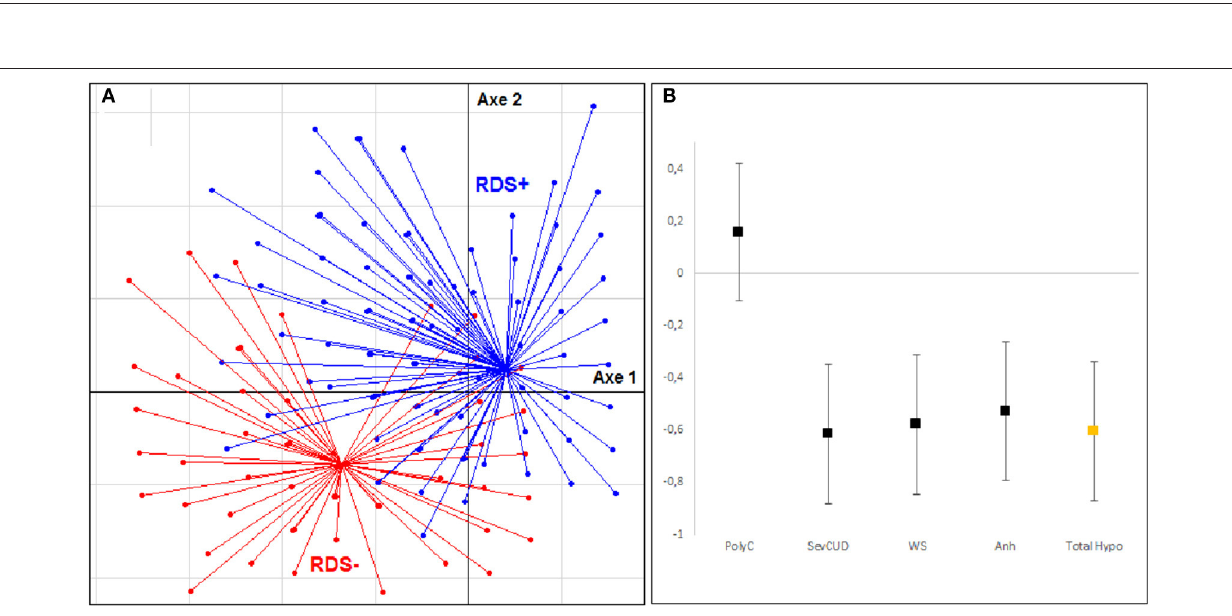
The analysis ( Figure 1A ) revealed that in the hyperdopaminergic component, our population was well separated into two groups between RDS + (blue) and RDS– (red)